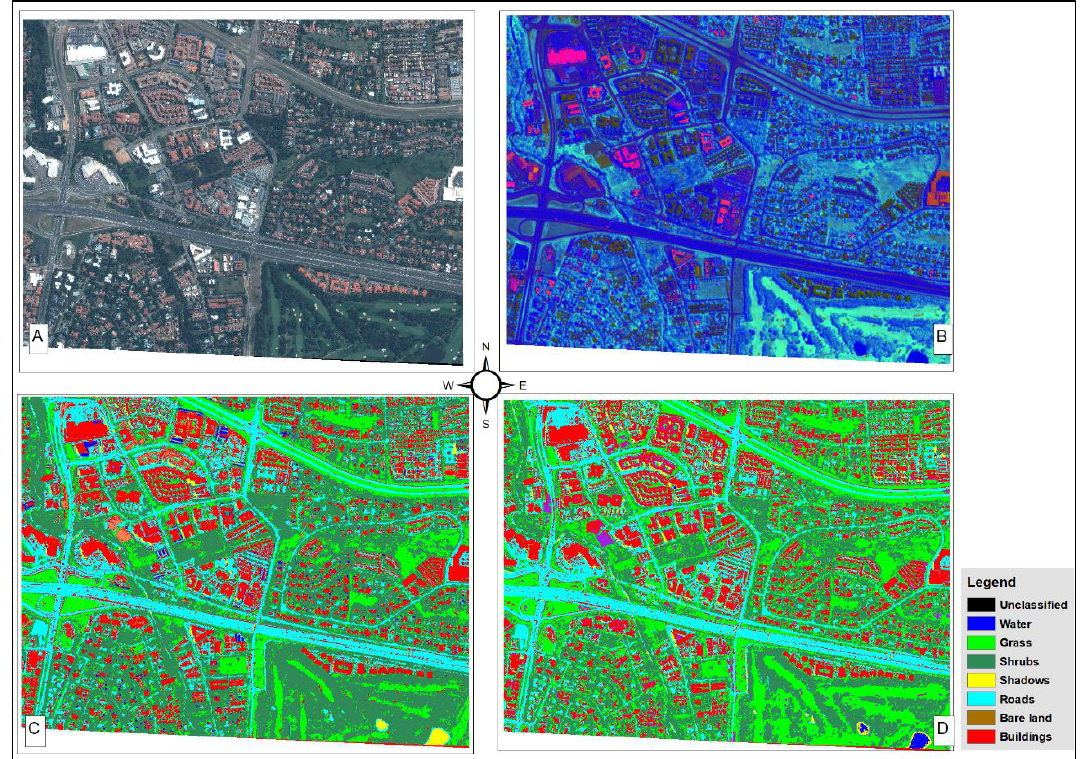
Figure 3. The classification results of the CMPs and MMPs algorithms in a different area (Sunninghill): (a) original Pleiades imagery; (b) filtered imagery using MP; (c) CMP classified imagery; (d) and MMP classified imagery.